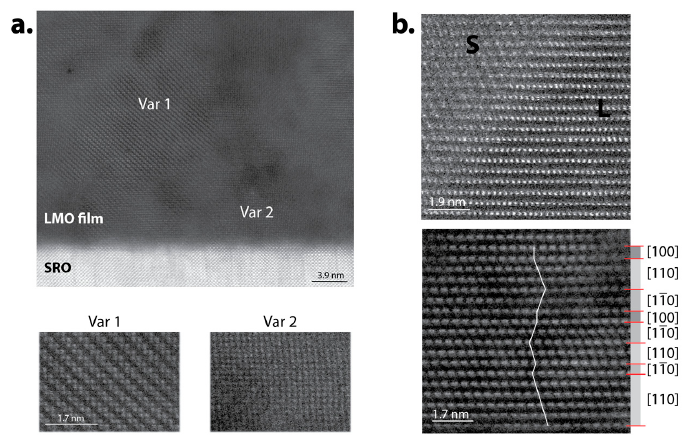
Figure 6. Cross-sectioned HAADF-STEM images of Li-Mn-O films grown at 600 °C on ( a ) SRO/STO(100) and ( b ) SRO/STO(111) substrates. The structure of the films was identified as monoclinic Li 2 MnO 3 . ( a ) A cross-section with STO in the [100] c zone axis shows two coexisting variants of m-Li 2 MnO 3 , Variant 1, with a [101] m zone axis, and Variant 2, with a [323] m zone axis; ( b ) Cross-sections with STO in [110] c (upper image), and with STO in [112] c (lower image) Li 2 MnO 3 in the [310] m and the [110] m /[100] m zone axes, respectively. (Images are taken from our previously published work, see Ref. [15]).